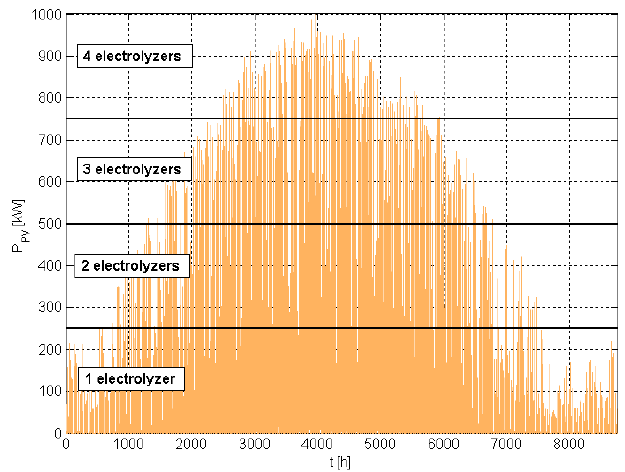
Figure 6. Impact of electricity production by PV installations on the number of working electrolyzers—own